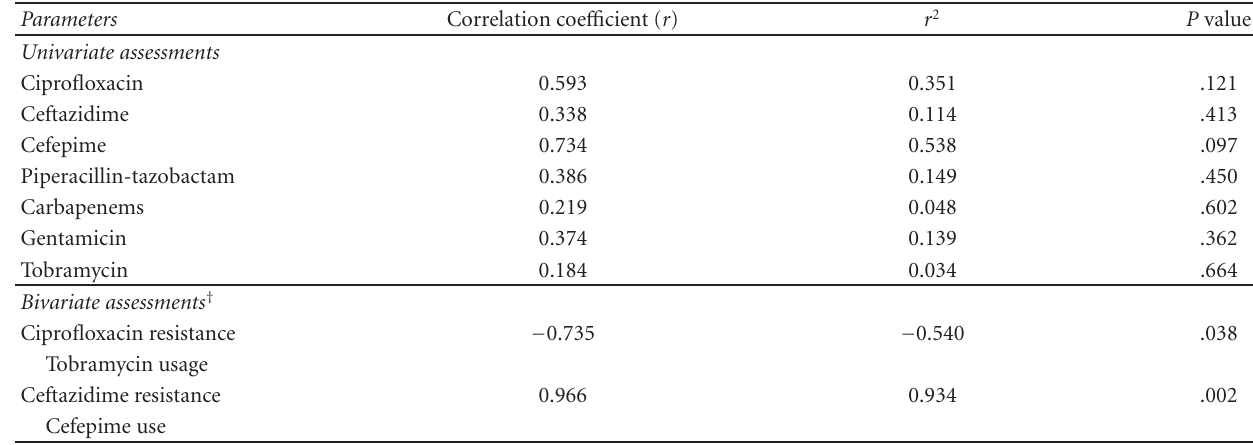
Table 2: Assessment of correlation between P. aeruginosa resistance and antibiotic usage.